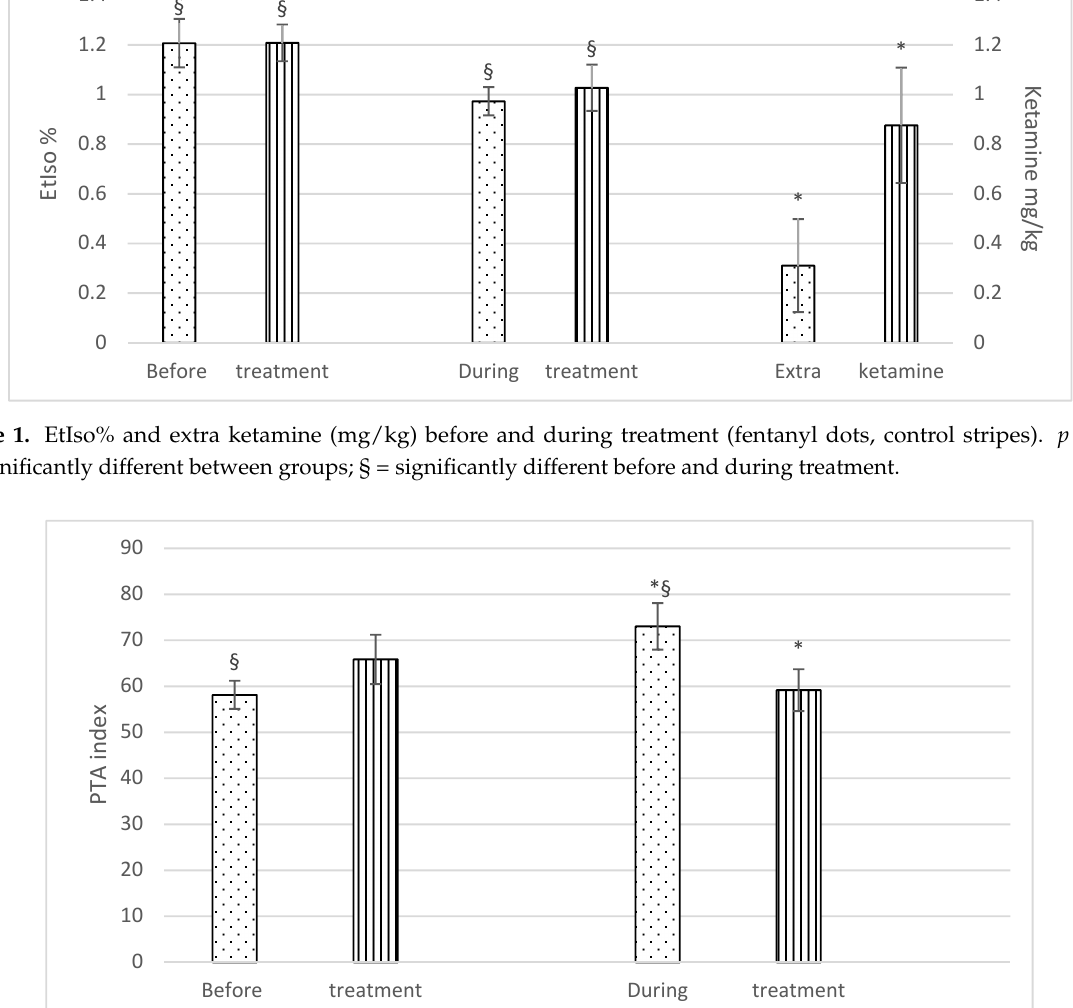
Figure 2. Mean PTA (± SD) of fentanyl (dots) and control (stripes) group, before and during treatment. p < 0.05. * = significantly different between groups; § = significantly different before and during treatment.